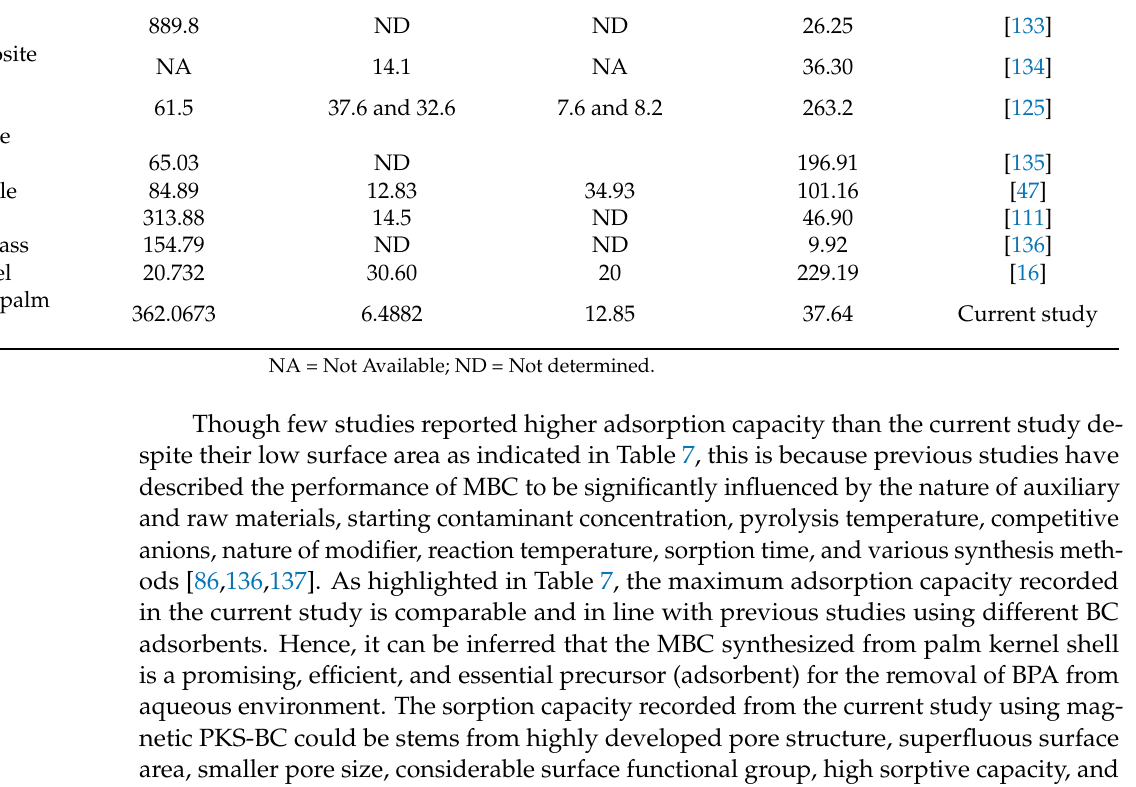
Table 7. Comparison of specific surface area, magnetic strength, and adsorption capacity of BPA on different adsorbents from previous literature with current study.